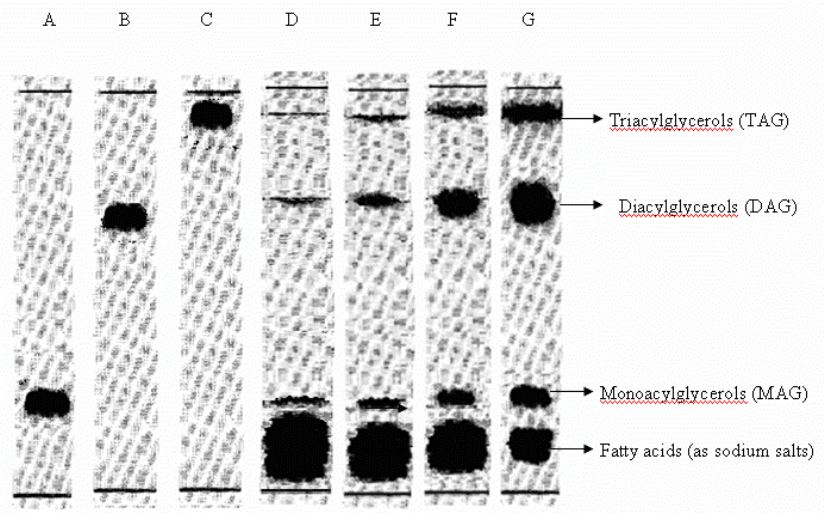
FIGURE 4. Chromatograms showing the fractionation of esterified product by TLC. Lane A, Lane B, Lane C are the standards of monoacylglycerol (MAG) (Rf = 0.26), diacylglycerol (DAG) (Rf = 0.72), and triacylglycerol (TAG) (Rf = 0.98), respectively. Lane D: the control reaction without the presence of lipase. Lane E, Lane F, and Lane G: the optimum esterification product fractions from reaction at 45, 55, and 65ºC, respectively [average Rf value: MAG (0.25), DAG (0.75), and TAG